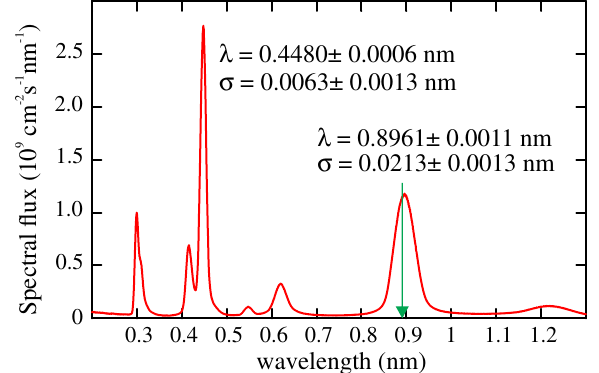
FIG. 6. Spectral neutron flux (not: neutron capture flux) from the center of the GRANIT beamline, obtained by time-of-flight measurement. The neutron capture flux measured at the position of the device is used for the normalization. The green arrow shows the useful wavelength for UCN production in the LHe source.